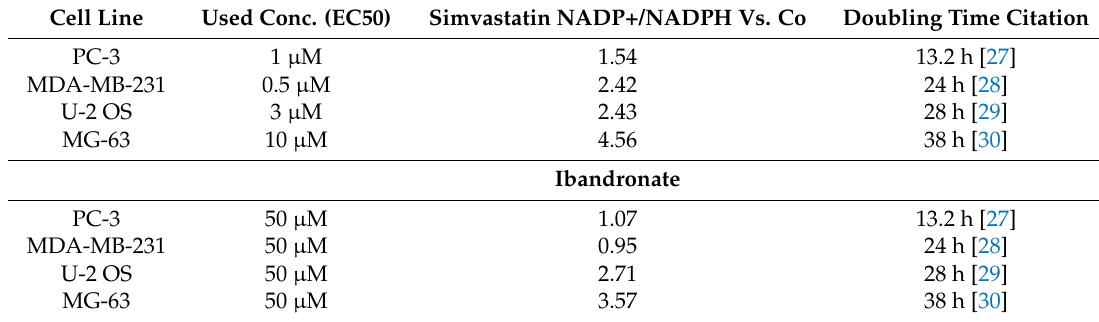
Table 5. Drug-induced increase of NADP + (in relation to NADPH) is associated with doubling time. Cell Line Used Conc. (EC50)